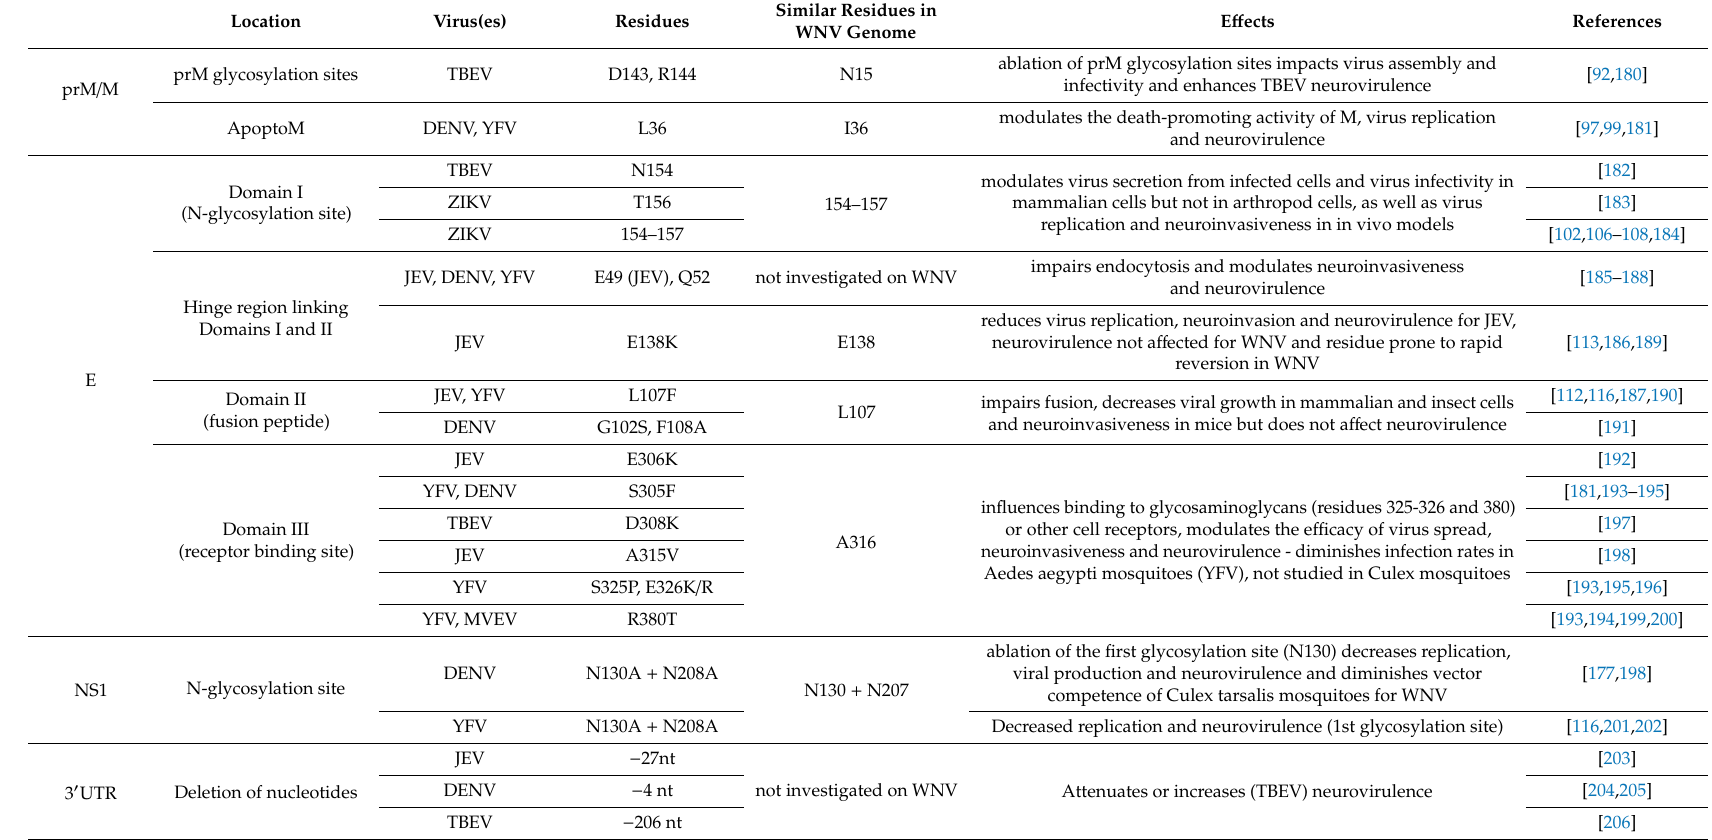
Table 2. Comparison of molecular virulence determinants among flaviviruses. The table details residues involved in virulence variation in vivo and in vitro and shared by at least two flaviviruses. TBEV: tick-borne encephalitis virus; DENV: dengue virus; ZIKV: zika virus; YFV yellow fever virus; JEV: Japanese encephalitis virus; MVEV: Murray valley encephalitis virus